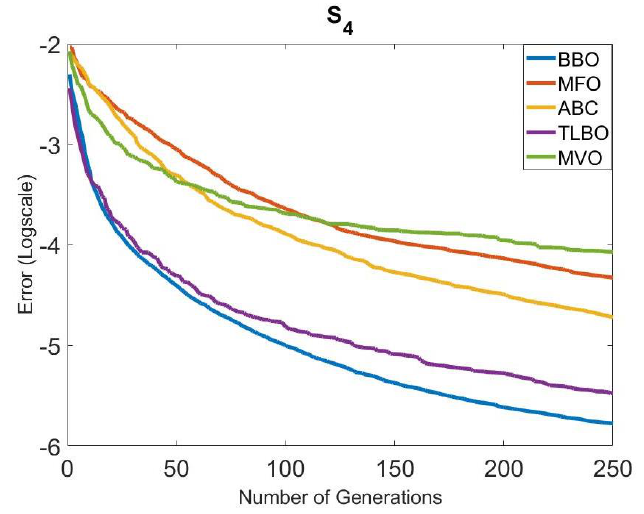
Figure 7. Comparison of the convergence of the metaheuristic algorithms in Group 1 for S 4 .